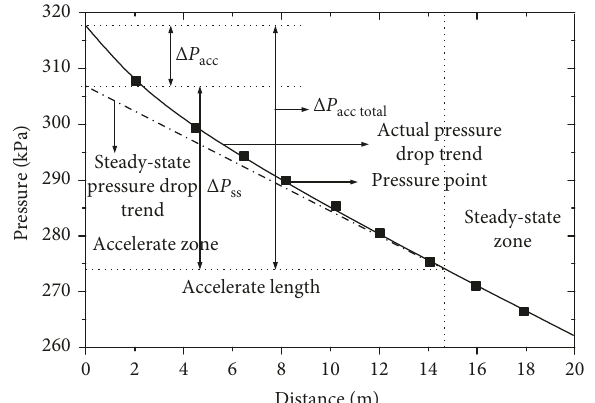
Figure 6: Trend of pressure drop during concrete